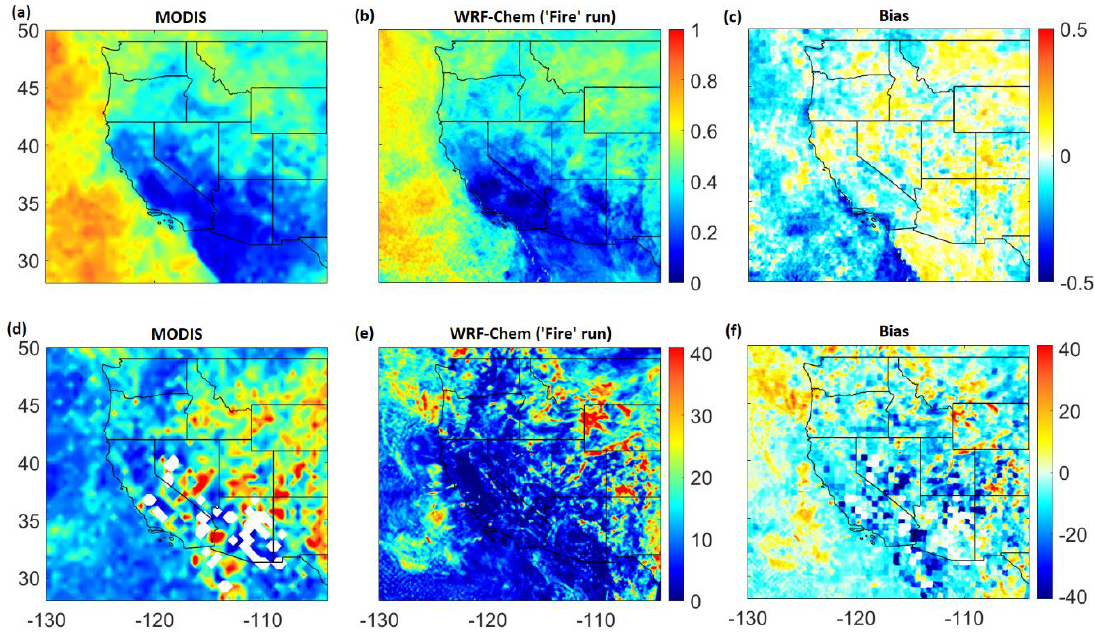
Figure 5. Cloud fraction ( a ) for MODIS, ( b ) for WRF-Chem model (‘Fire’ run) and ( c ) Bias between model and MODIS. Additionally shown is cloud optical depth (COD) ( d ) for MODIS, ( e ) for WRF- Chem model (‘Fire’ run), and ( f ) Bias between model and MODIS.